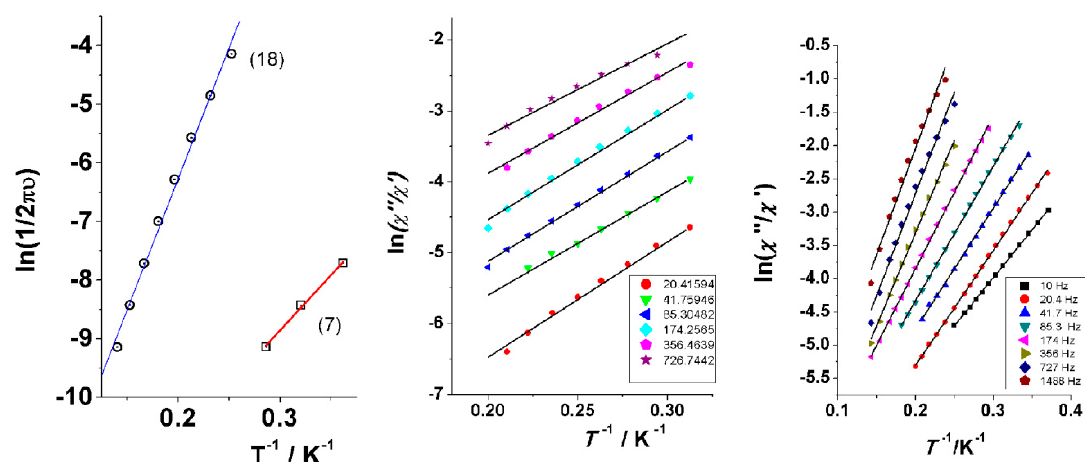
Figure 14. ( left ) Arrhenius plots for complexes 7 _Dy and 18 _Dy in applied dc fields of 0.1 T, ( center ) plots of ln( χ ″ M / χ ′ M ) vs. 1/ T for 17 _Tb at different ac frequencies in an applied field of 0.15 T, and ( right ) plots of ln( χ ″ M / χ ′ M ) vs. 1/ T for 7 _Dy at different ac frequencies in an applied field of 0.1 T. The solid lines represent the fits.